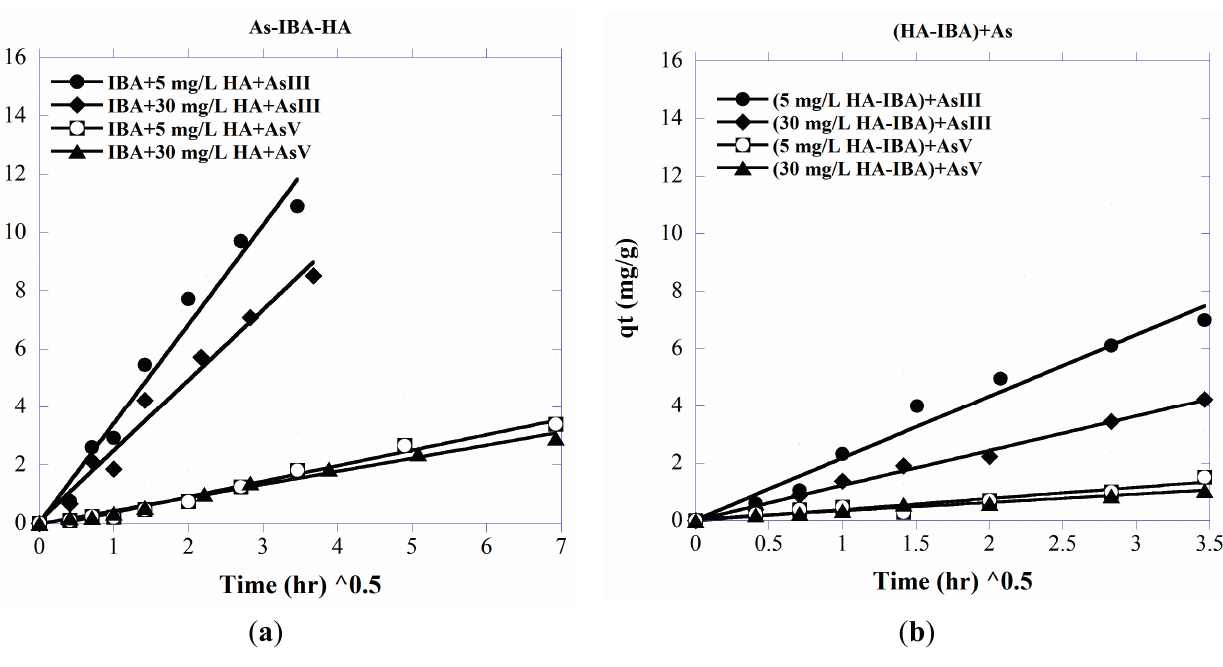
Figure 11. Weber and Morris intra-particle diffusion plots for removal of As species (5 mg/L) in ( a ) co-adsorption with HA and ( b ) IBA preloaded with HA at different HA concentrations, pH = 7.5 and room